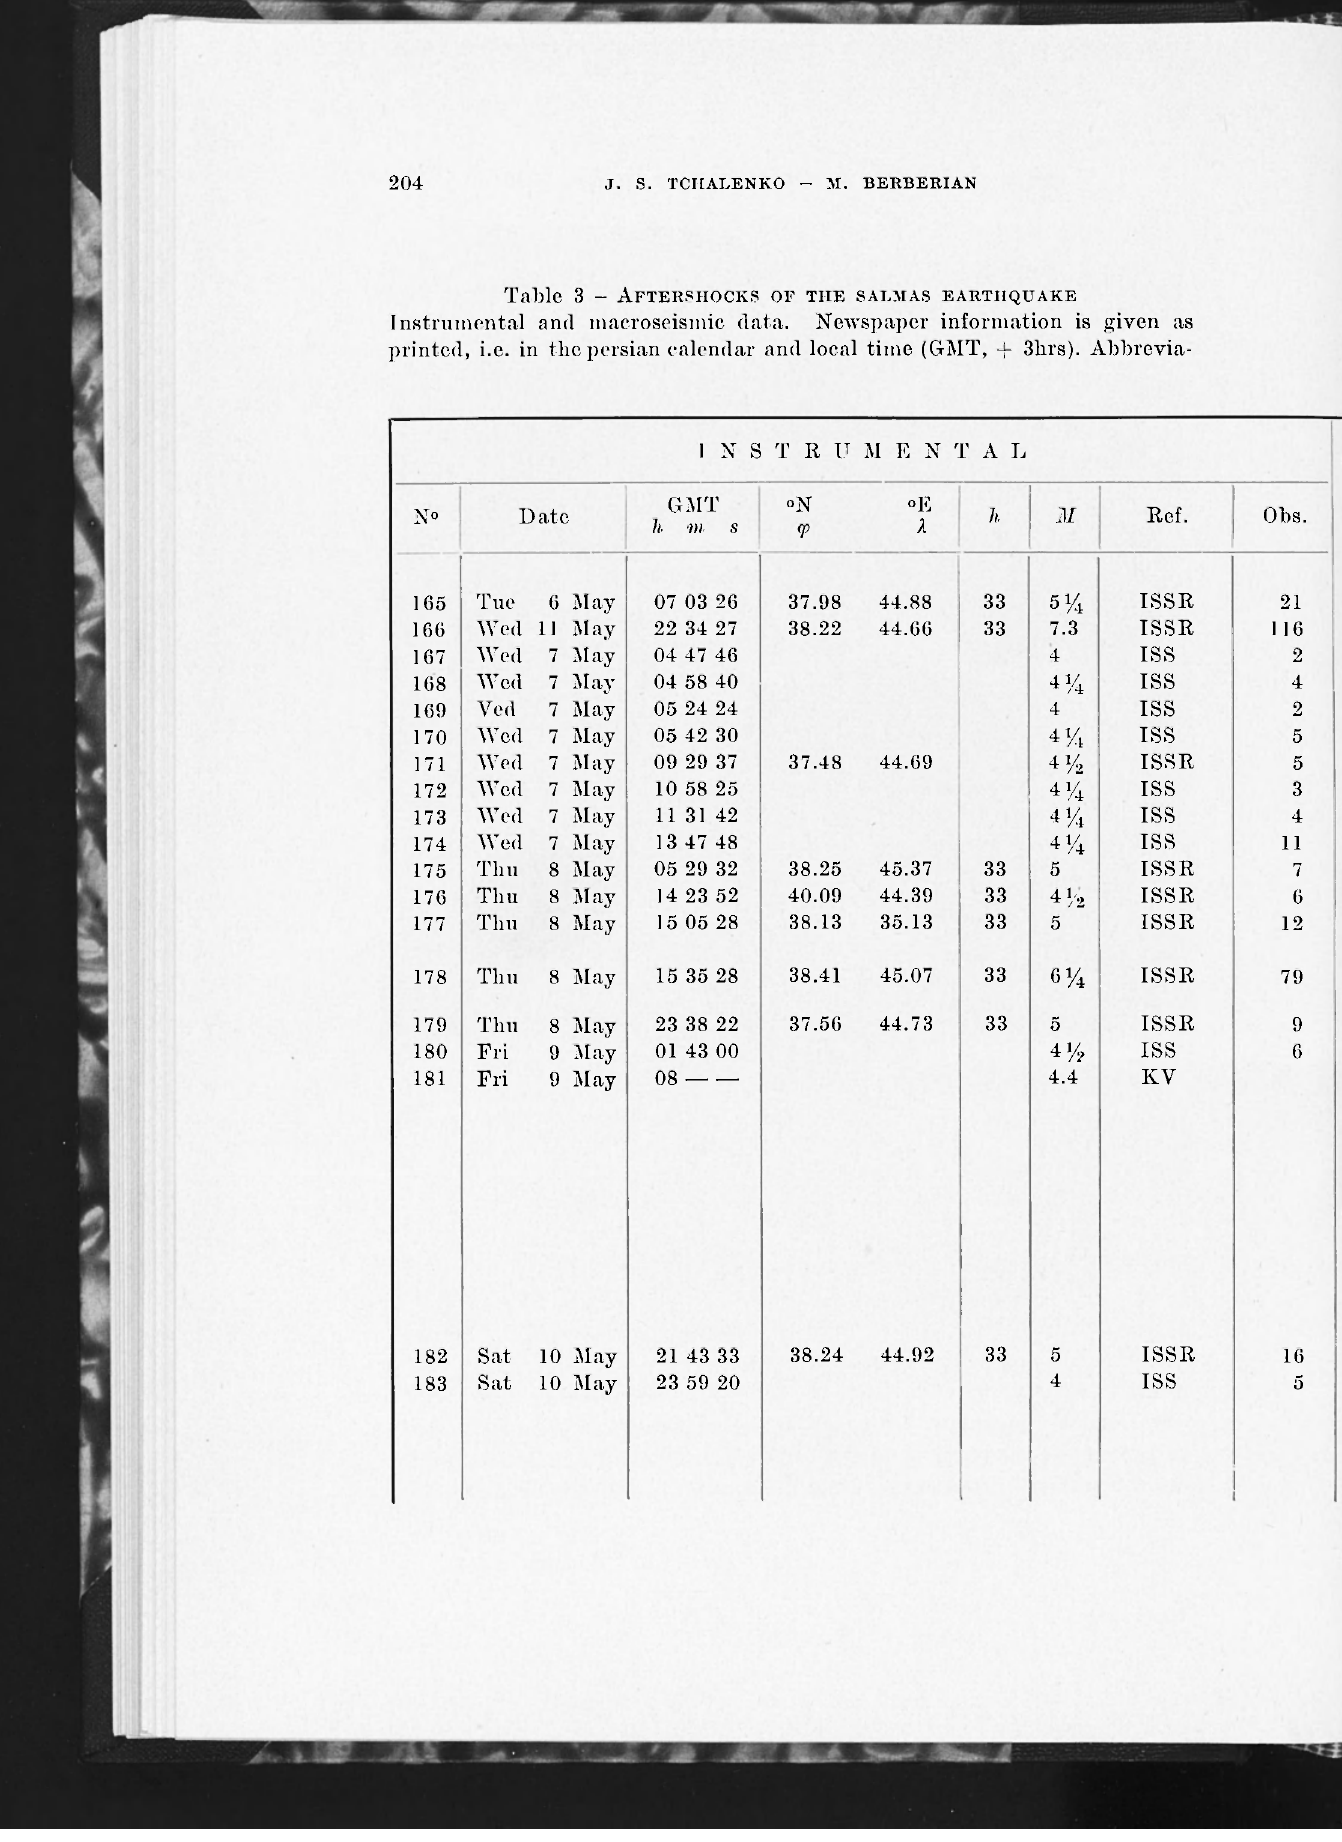
Table 3 - AFTERSHOCKS OF THE SALMAS